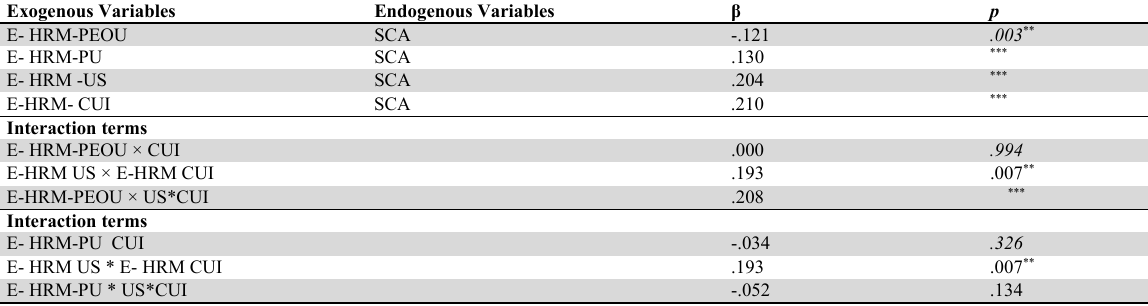
Three-way moderation effect of user satisfaction and e-HRM